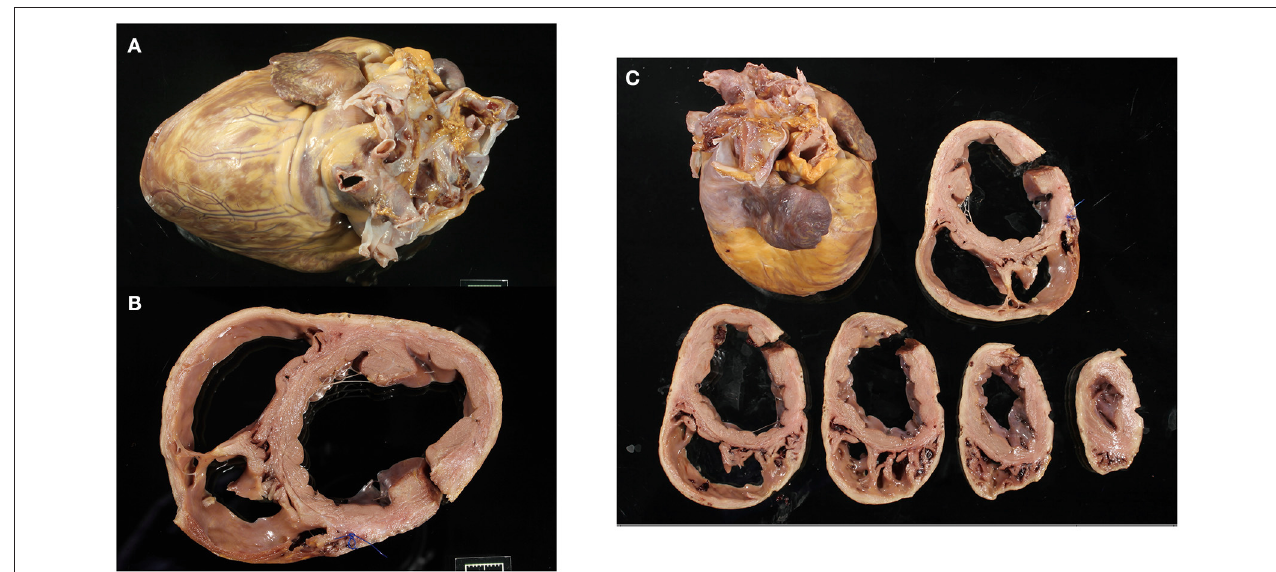
FIGURE 1 | Representative gross images of a Golden Retriever muscular dystrophy heart showing the whole heart (A) , the basal cross-section with left ventricle and right ventricle dilation (B) , and all ventricular cross-sections (C) .